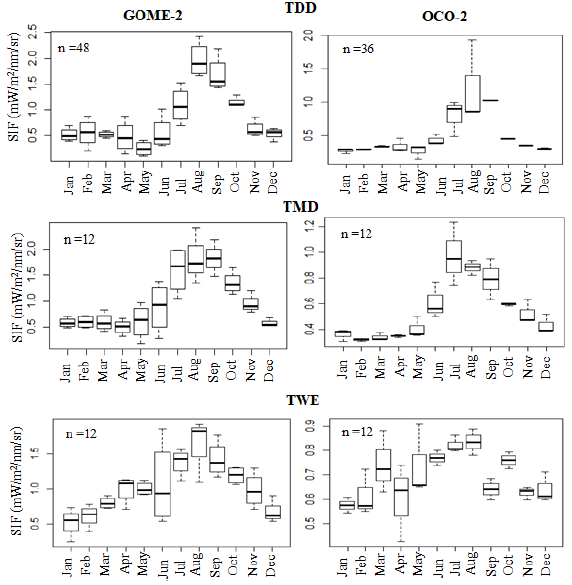
Figure 3. Intra-annual trend of SIF derived from GOME-2 (left) and OCO-2 (right) for different forest type. 3.1.1 Tropical Dry Deciduous (TDD): GOME-2 SIF